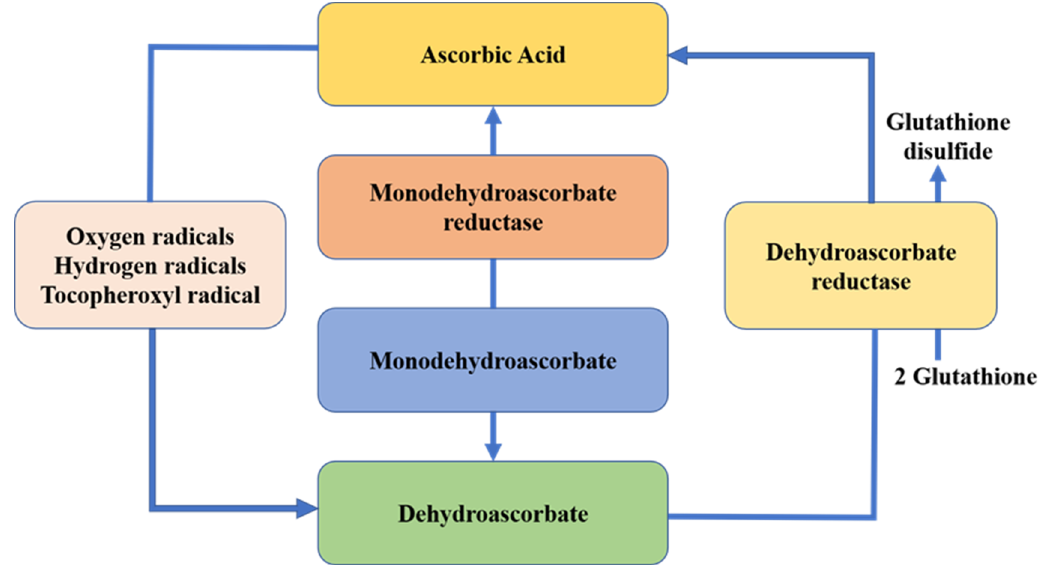
Figure 5. Ascorbic acid decay and regeneration cycle. Adapted from [22].